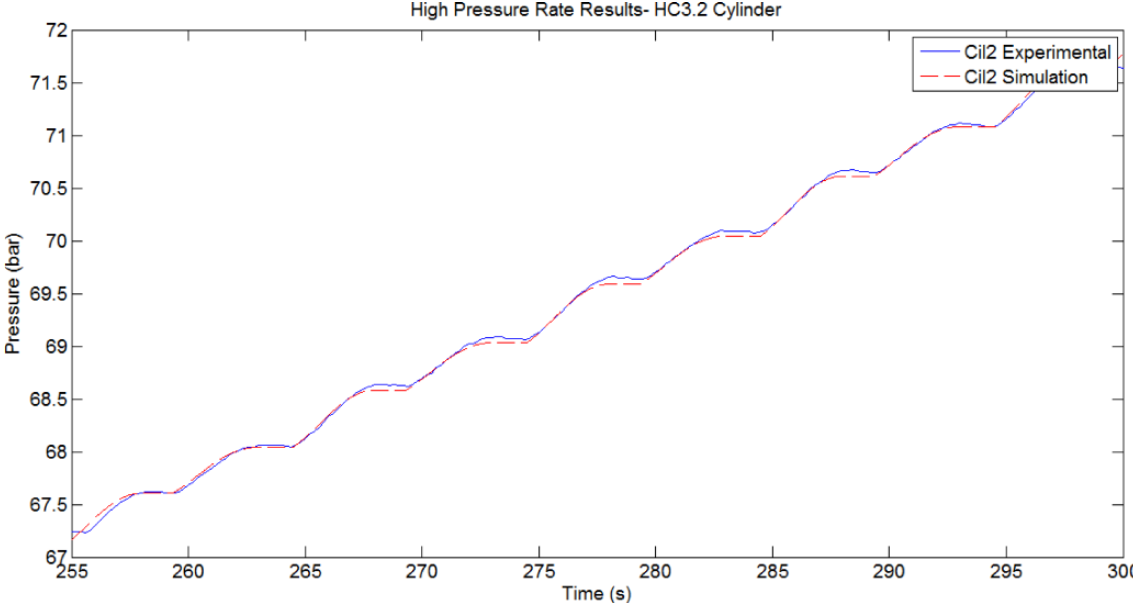
Figure 23. Comparison between Simulated and Experimentally Measured pressure of HP Accumulator. Active cylinder HC3.2. Initial Pres. 67.2 bar. Geometrical layout: Config